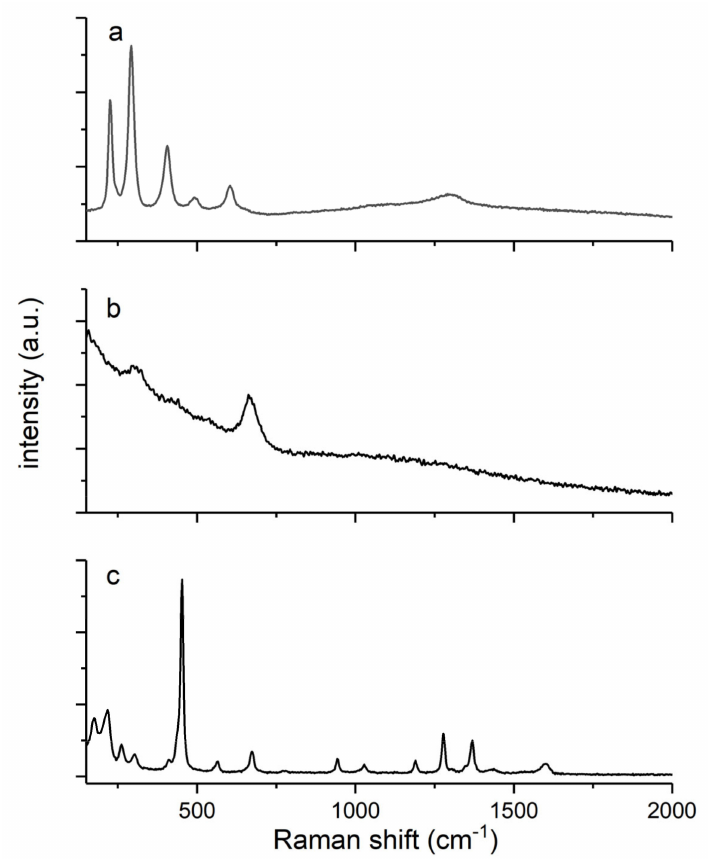
Figure1. Ramanspectraofsynthesizediron-basedfiller:( a )hematite;( b )magnetiteand( c )tris(acetylacetonato)